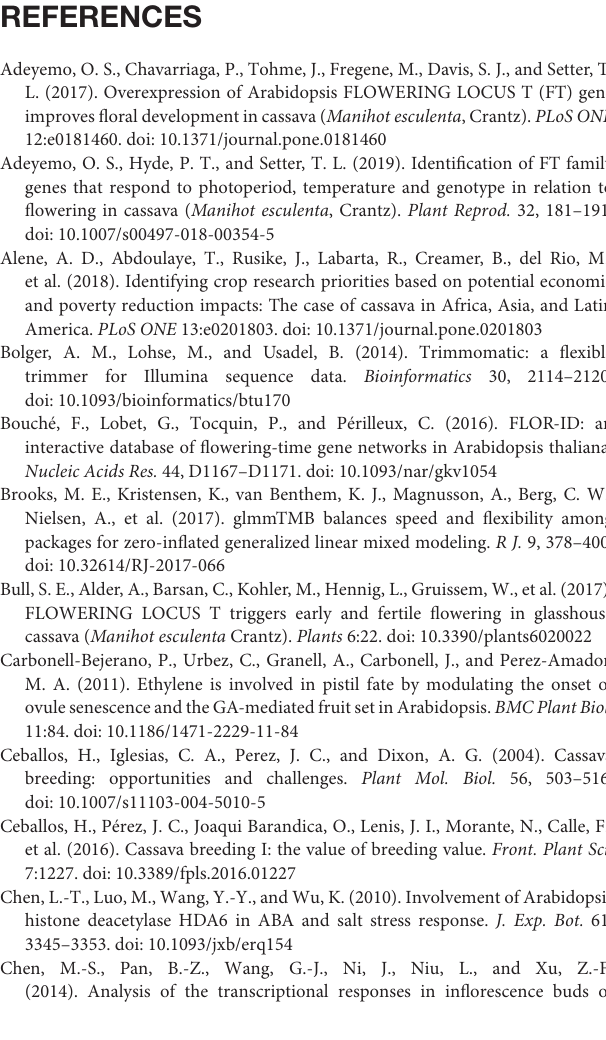
Supplementary Table 1 | Worksheet 2017: Results of negative binomial and binomial mixed model regression. Incidence rate ratio (IRR) and odds ratio with